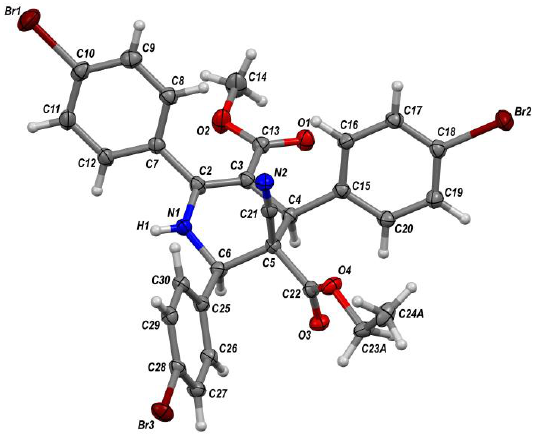
Figure 2. X-ray structure of the 5a 4 RS ,5 SR ,6 RS configuration.